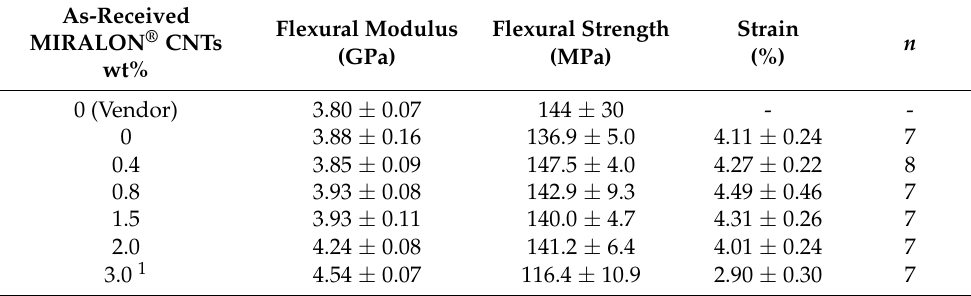
Table 1. Flexural properties ( µ ± δ ) of compression molded epoxy and as-received CNT/epoxy